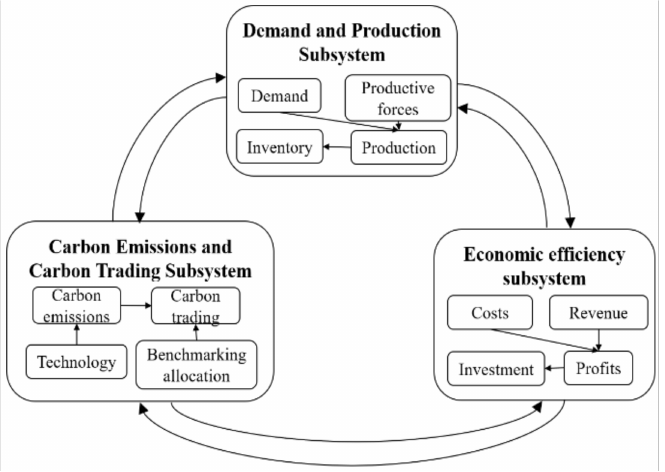
Figure 2. Subsystem framework diagram of the system dynamics